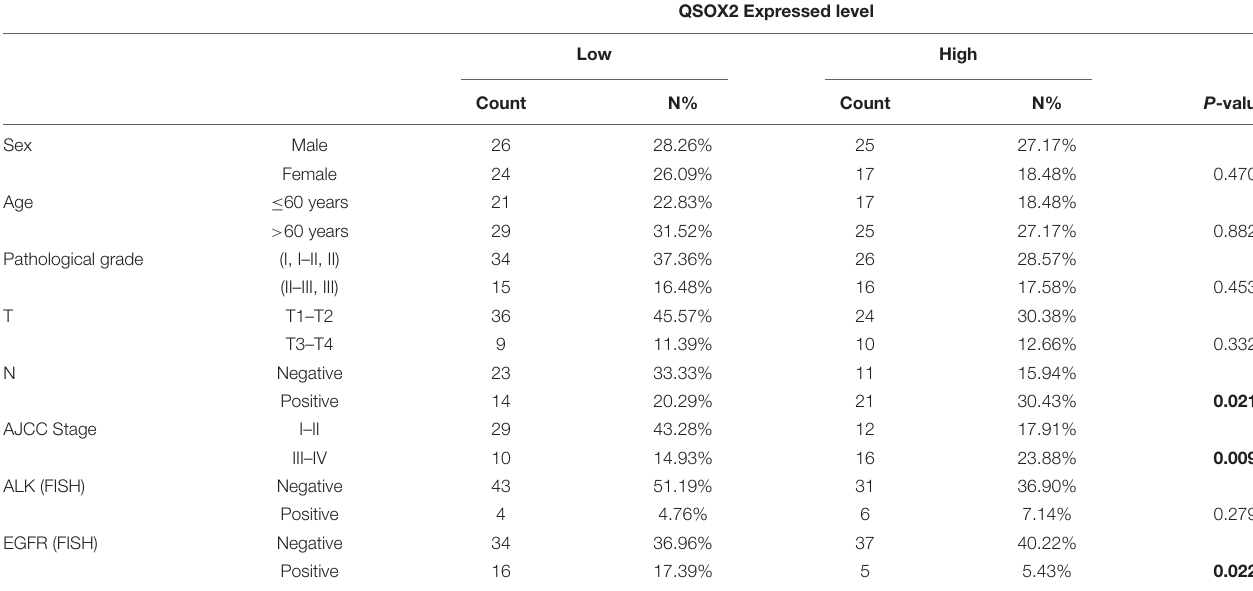
TABLE 1 | Association of QSOX2 expression levels with clinicopathologic characteristics in